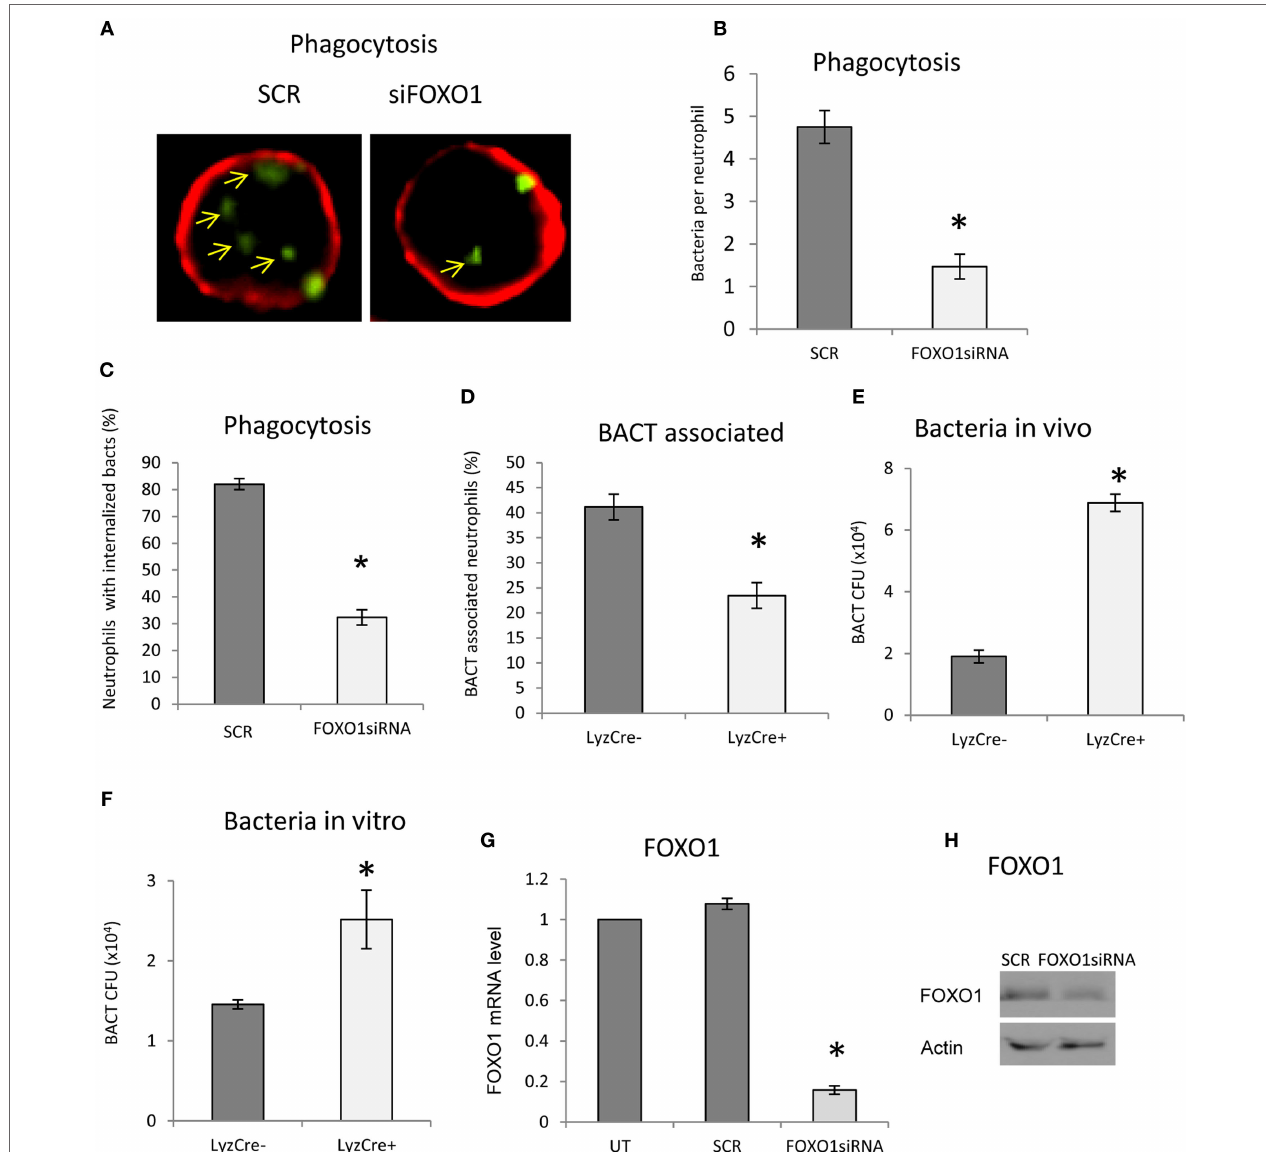
FigUre 3 | FOXO1 deletion impairs neutrophil bacterial phagocytosis. (a) Carboxyfluorescein succinimidyl ester ( CFSE )-labeled bacteria were incubated with human HL-60 neutrophils transfected with scrambled or FOXO1siRNA. Deconvolution fluorescent microscopic images were taken after the neutrophils were stained with Alexa 647-labeled wheat germ agglutinin (WGA) to delineate the cell surface (red) and internalized bacteria (green). Internalized bacteria were considered as those within WGA-labeled plasma membranes. (B) Internalized bacteria expressed as the number of bacteria internalized per cell. (c) The percent neutrophils with phagocytosed bacteria. (D) The percent neutrophils with associated bacteria. (e) FOXO1-deleted LyzM.Cre + FOXO1 L/L and control LyzM.Cre − FOXO1 L/L mice were inoculated with Porphyromonas gingivalis in vivo . Live bacterial CFUs were measured. (F) Neutrophils from FOXO1-deleted LyzM.Cre + FOXO1 L/L mice and littermate control LyzM.Cre − FOXO1 L/L mice were isolated and incubated with P . gingivalis in vitro . Viable bacterial CFUs were counted. (g) RNA was isolated from neutrophils and FOXO1 was measured by real-time PCR. (h) Neutrophils transfected with the siRNA were analyzed by Western blots using a antibody specific for FOXO1. Actin was assessed as a loading control. The data are representative of two or three independent experiments of mean ± SEM from triplicate samples. *Significant difference between human neutrophils from transfection of FOXO1 siRNA vs. scramble siRNA ( P < 0.05). *Significant difference between neutrophils from FOXO1-deleted LyzM.Cre + FOXO1 L/L mice and littermate control LyzM.Cre − FOXO1 L/L mice ( P < 0.05). SCR, scrambled siRNA; UT, untransfected control.